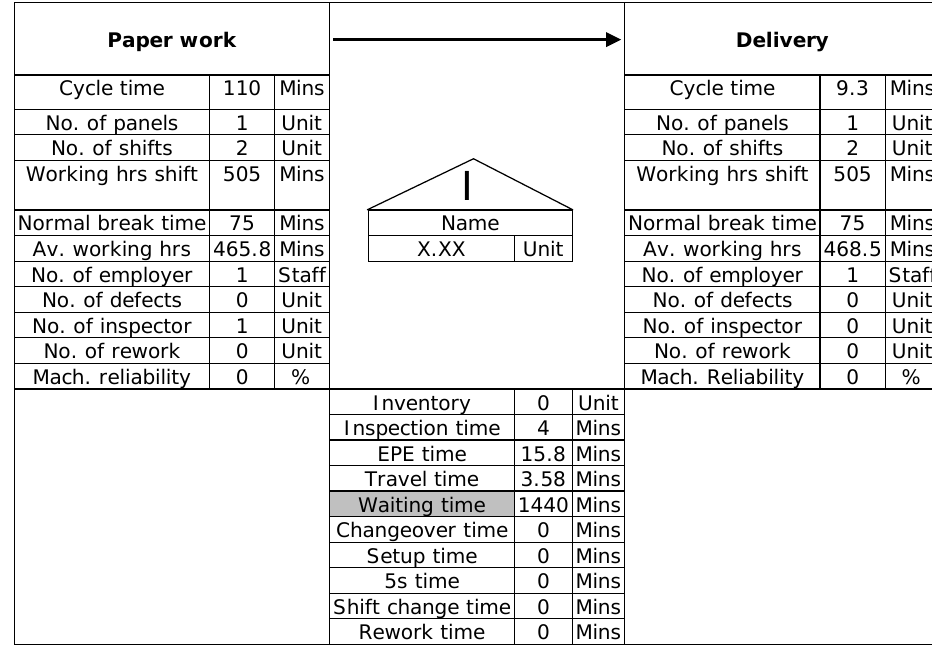
Figure 6. “Travel time wastages (paperwork to delivery)”.